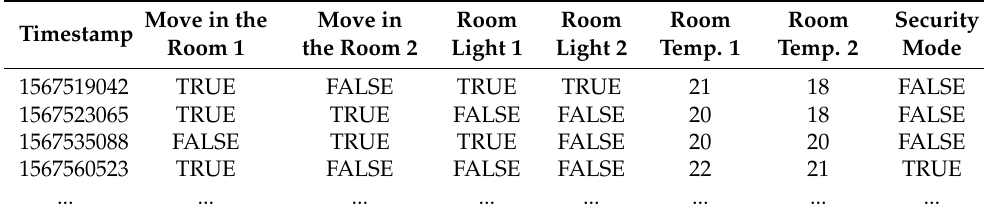
Table 1. A fragment of the training sample data.